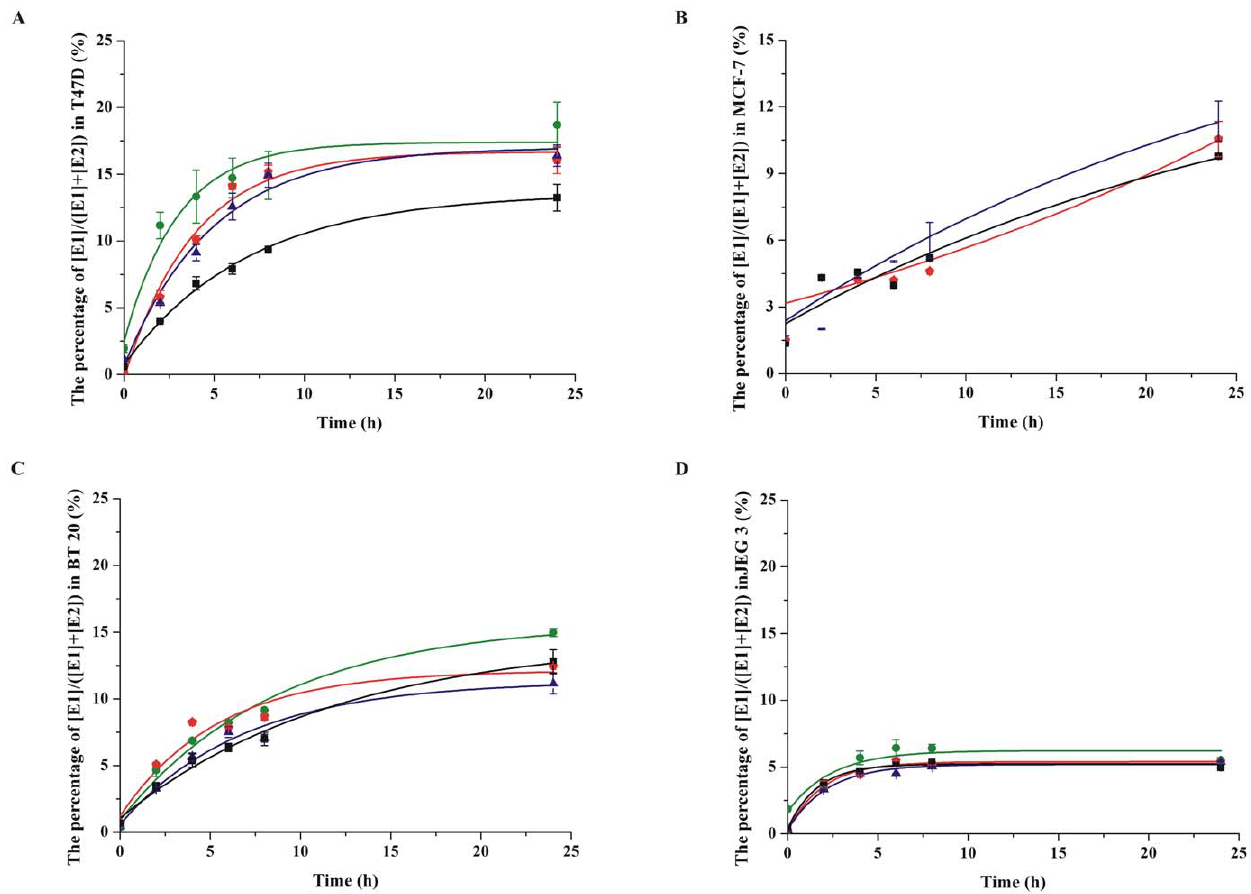
Figure 2. The conversion of E2 to E1 in T47D, MCF-7, BT 20 and JEG 3 cells. 50,000 cells were plated onto 24-well plates, and different concentrations of E2 (0.01 m M, 0.05 m M, 0.1 m M and 0.3 m M) were added to dextran-coated charcoal treated medium. E1 production was evaluated at 0 h, 2 h, 4 h, 6 h, 8 h and 24 h. Choosing 0.01 m M, 0.05 m M, 0.1 m M and 0.3 m M E2 as the substrate are represented by green, red, blue and black lines respectively. Experiments were performed in duplicate, and all the data are fit to sigmoidal or exponential distribution (S.D. # 1%).